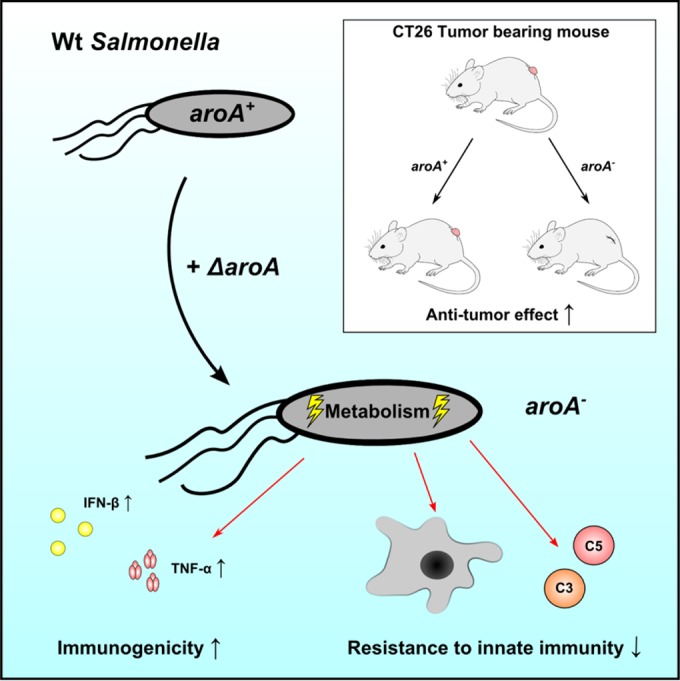
Graphic summary showing the effects of ΔaroA in Salmonella. The deletion of aroA acts globally on Salmonella, leading to increased immunogenicity, increased susceptibility toward components of the innate immune system, and increased therapeutic efficacy in bacterium-mediated tumor therapy.